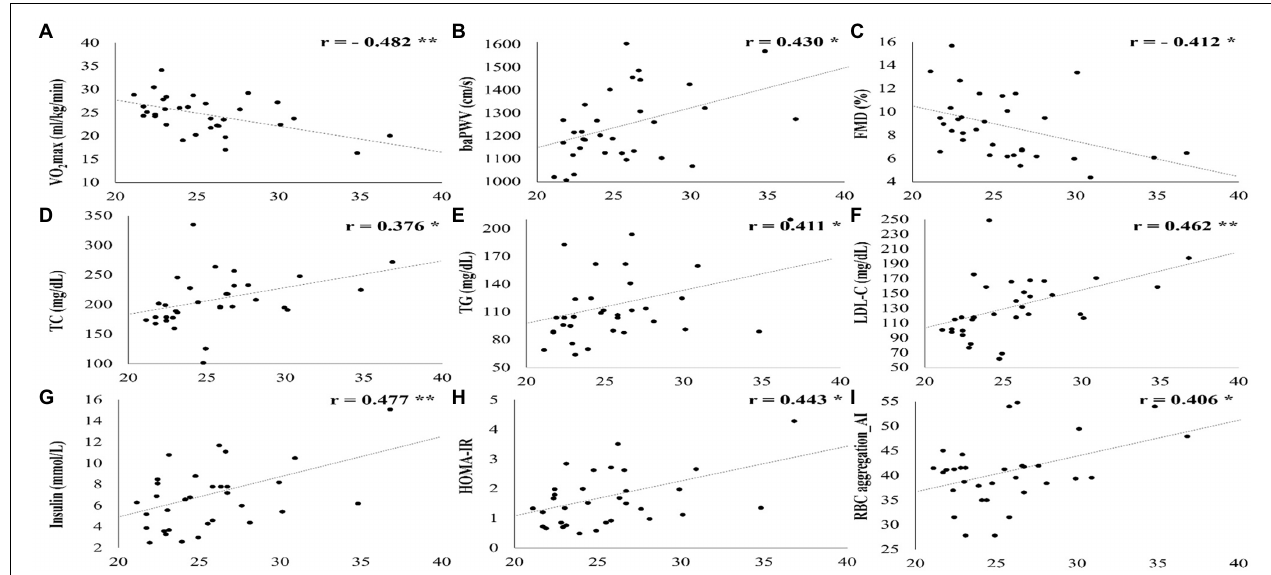
FIGURE 3 | All parameters that showed a significant correlation with BMI. SD, standard deviation; VO 2 max, maximal oxygen uptake; baPWV, branchial ankle pulse wave velocity; FMD, flow-mediated vasodilation; TC, total cholesterol; LDL-C, low density lipoprotein cholesterol; HOMA-IR, homeostatic model assessment for insulin resistance, RBC, red blood cell; and AI, aggregation index. * p < 0.05; ** p < 0.01; *** p <